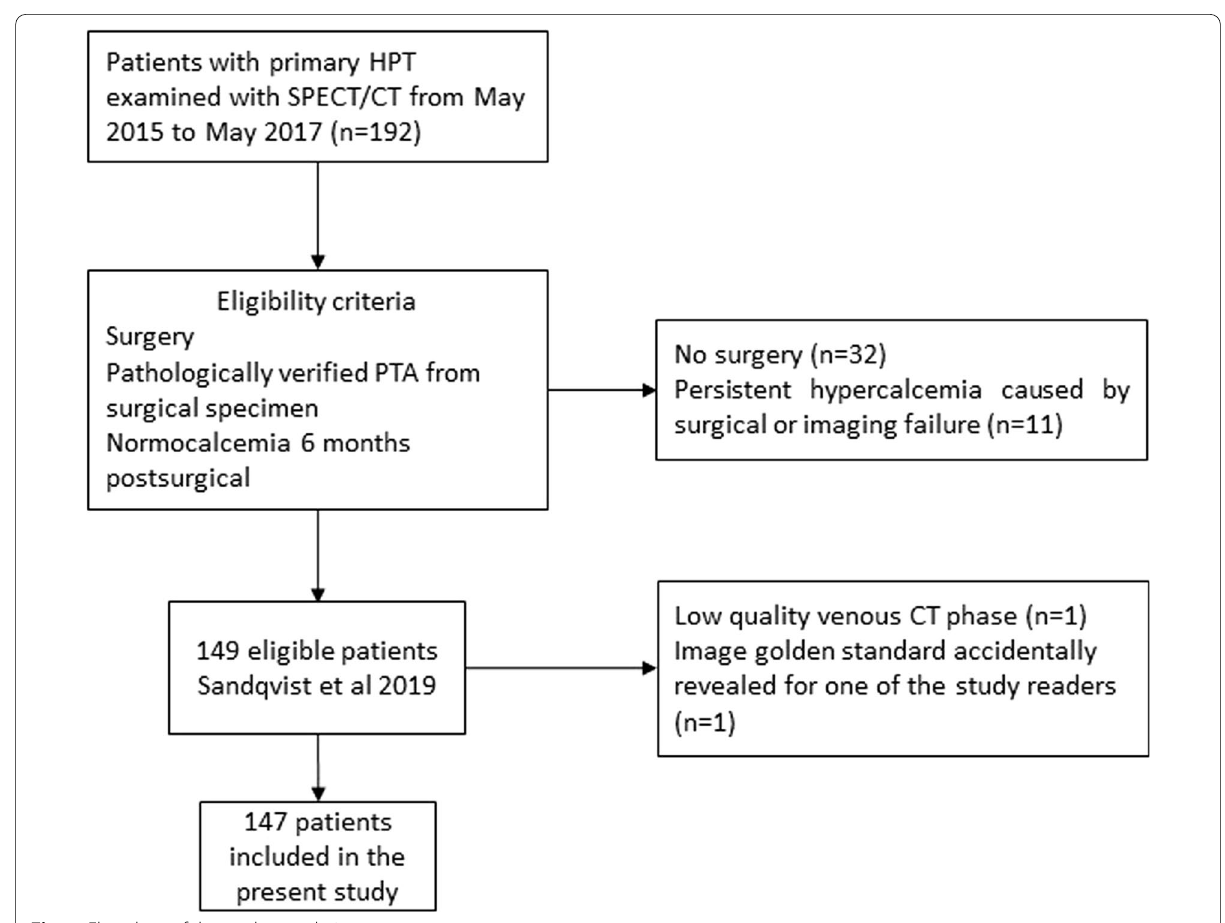
Fig. 1 Flowchart of the study